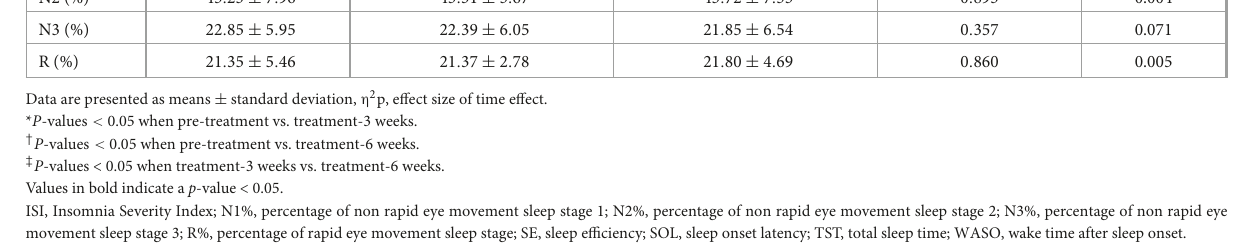
TABLE 2 Daytime sleepiness, fatigue, mood status, and attention levels before and after electrostatic